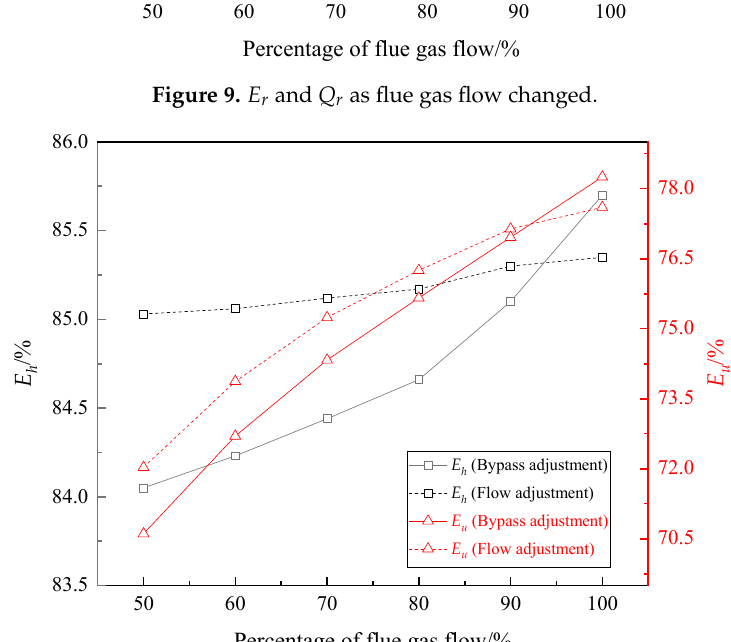
Figure 10. E h and E u as flue gas flow changed.